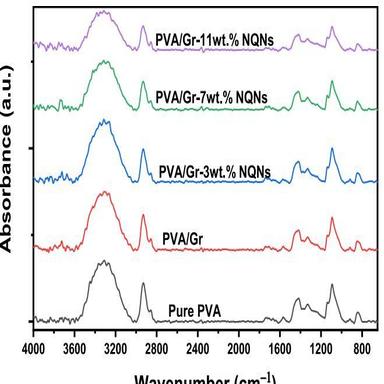
FTIR absorption spectra of pure PVA, Gr, NQNs, and the fabricated PNCs (PVA/Gr, PVA/Gr-3 wt% NQNs, PVA/Gr-7 wt% NQNs, and PVA/Gr-11 wt % NQNs).